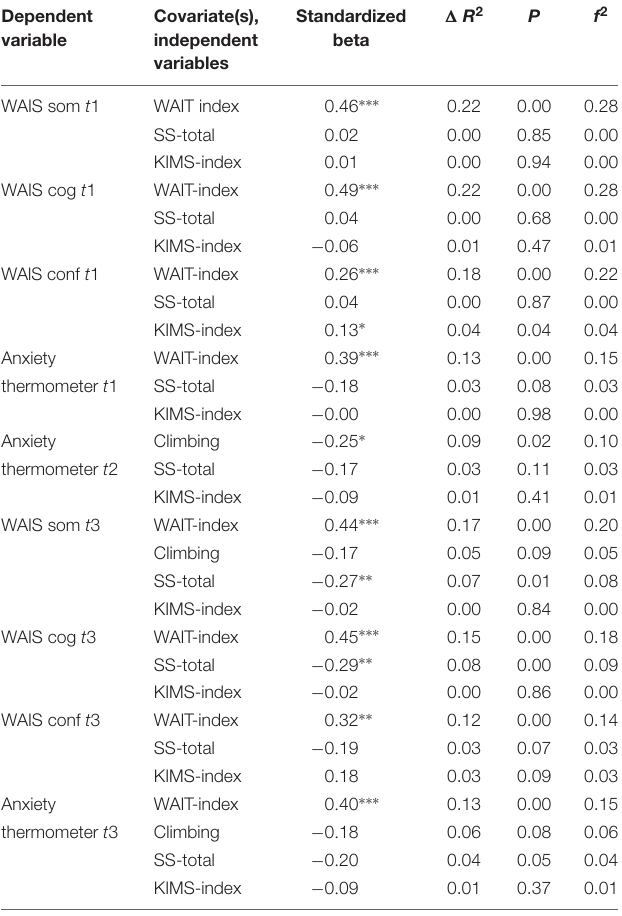
TABLE 5 | Hierarchical regressions of the dependent variables on SS and KIMS and the respective